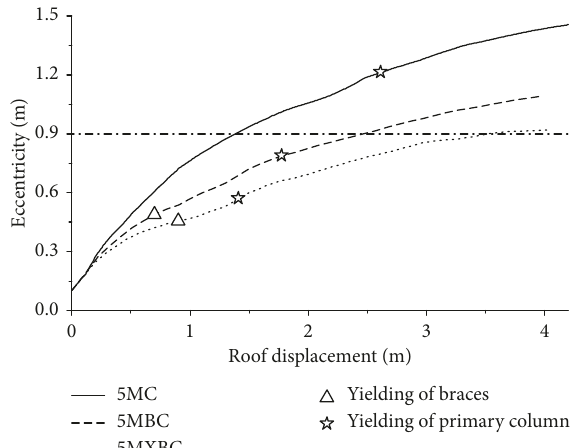
Figure 10: The eccentricity curves of primary column in three model structure: 5MB, 5MBC, and 5MXBC (the eccentricity represents the ratio of bending moment to axial force).